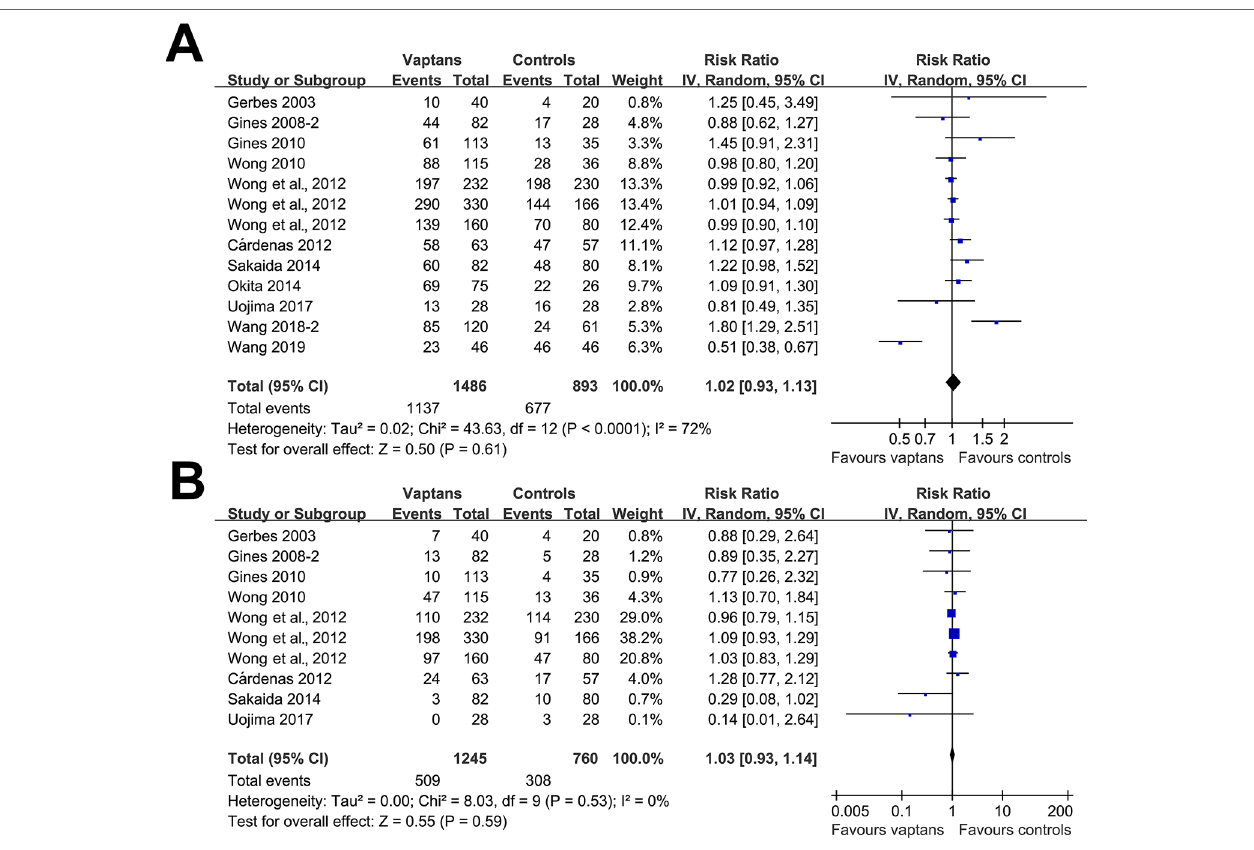
FIGURe 4 | Forest plots for meta-analysis of the influence of vaptans on the risk of adverse events in cirrhosis patients. (A) Incidence of total adverse events. (B) Incidence of serious adverse